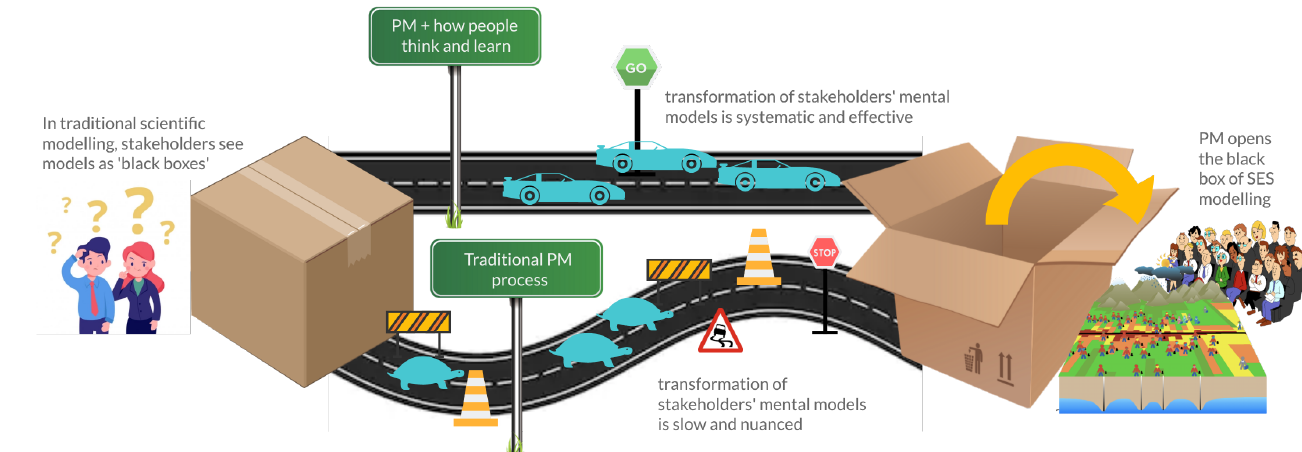
Figure 1. In PM, practitioners and stakeholders often face the challenge of ‘coming together’ to create an impact beyond the model being produced. By integrating an understanding of human barriers into the process, PM practitioners can design strategies to bypass those obstacles, drawing from other fields of study that examine how people think, learn, and behave. Modelling with value-driven and biased stakeholders requires a transdisciplinary and learning skill-set, as an active responsibility of PM practitioners in order to ‘open’ up the modelling